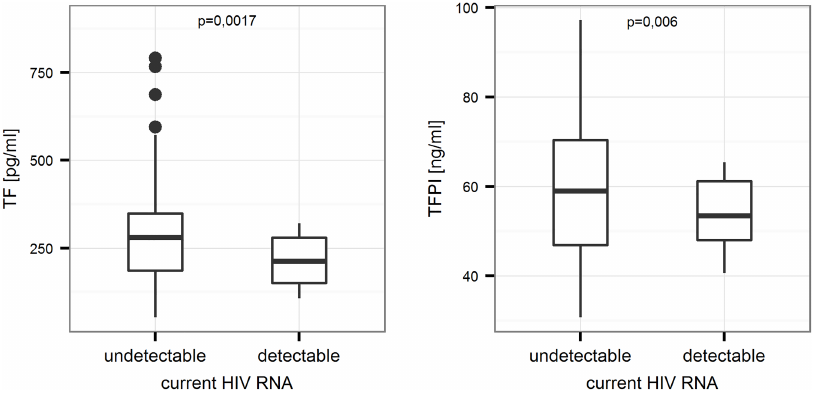
Fig 1. Comparison of concentrations of TF and TFPI between patients with detectable and undetectable levels of HIV RNA in the study group (p = 0.0017 and p = 0.006, respectively). Mann- Whitney